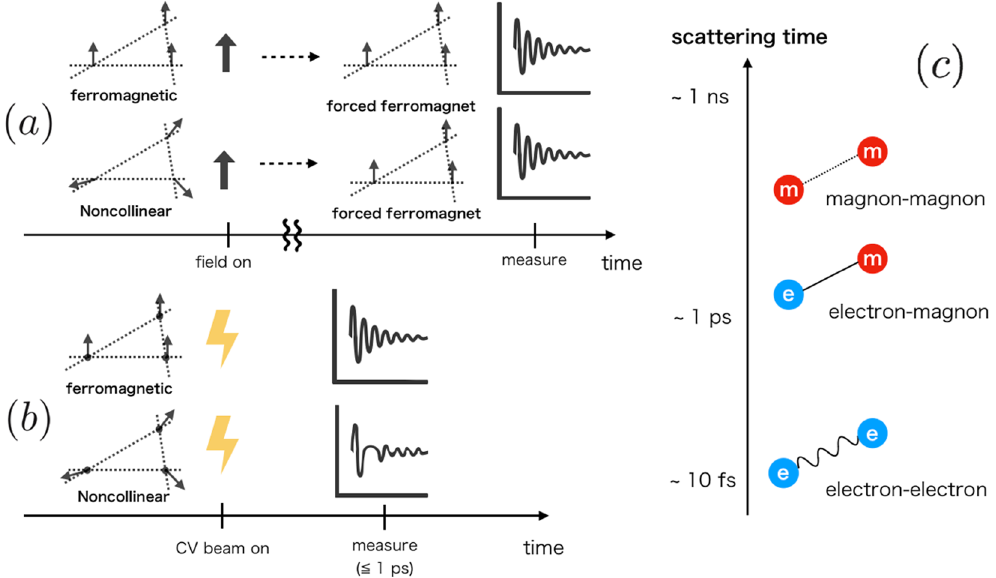
Figure 1. ( a ) Schematics of conventional magnetic oscillation measurement performed to a conducting magnet. Arrows on vertices of the lattice represent localized moments, and the thick black arrows do the static magnetic field perpendicular to the lattice. Irrespective to the original spin texture, the static field makes the system to be a forced ferromagnet. ( b ) Schematics of laser-based nonequilibrium measurement proposed in this paper. We apply a cylindrical vector (CV) beam (explained later) pulse to form the Landau levels to which electrons relax. The latter method has the sensitivity to the magnetic structure of the initial state. Panel (c) shows the hierarchy of the scattering times in solids 25–27